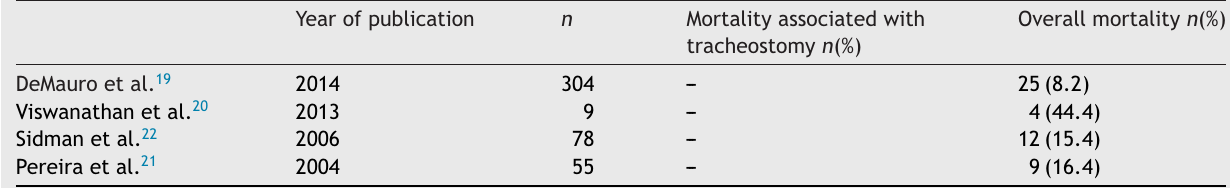
Mortality rates in premature and/or extremely underweight children who received a tracheostomy between 1985 and